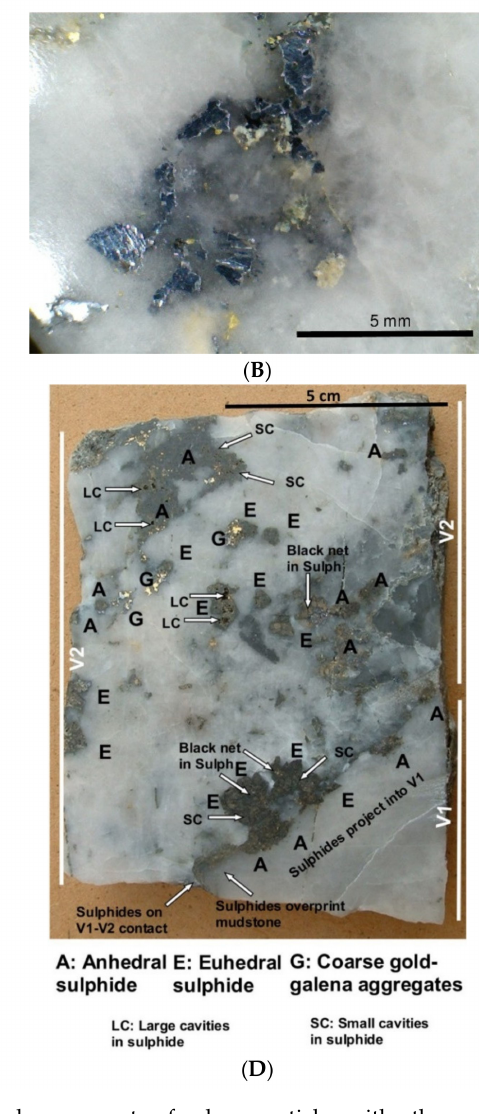
Figure 10. Aspects of sulphide occurrence. ( A ) Sample B1, irregular aggregate of galena particles with other sulphides intergrown. Gold (100–500 µ m) present in field of view. ( B ) Sample B1, chains of single galena particles in clear quartz. ( C ) Sample B4, galena, chalcopyrite, and clear quartz aggregate filling pseudomorph of euhedral sulphide phase. ( D ) Sample D2, hand specimen showing altered sulphide with euhedral and anhedral forms, gold is visible in these on the actual sample. The coarsest gold is visible in galena-gold